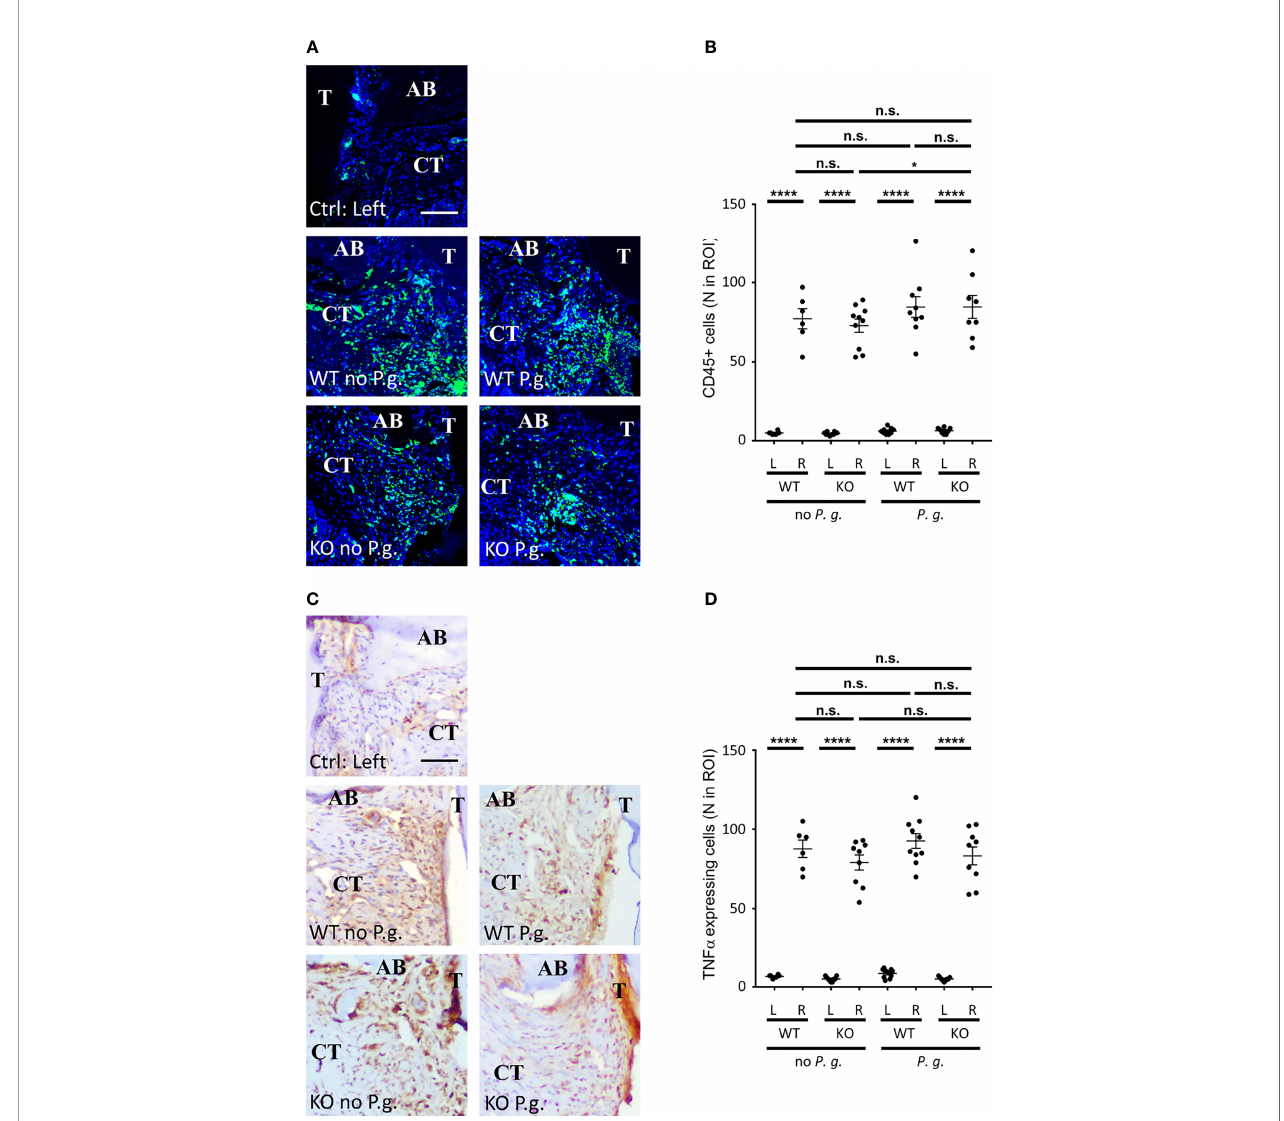
FIGURE 3 | CD45+ cells and TNF- a expression in connective tissue. (A) CD45 expression was revealed by immuno fl uorescence. (B) The number of CD45 + cells in a standardized ROI (ROI = 0.082 mm 2 ) was quanti fi ed. (C) TNF- a expression was revealed by immunohistochemistry. (D) The number of TNF- a -expressing cells (brown staining) in a standardized ROI (ROI = 0.082 mm 2 ) was quanti fi ed. (A, C) The control without periodontitis induction (left side) is shown on the individual upper panel, the assays with ligature with or without P. gingivalis (right side) are shown on the 4 lower panels (CT = connective tissue, AB = alveolar bone), scale bars = 50 m m. (B, D) Each dot represents a single mouse. Horizontal bars represent the mean +/- SEM. Ordinary one-way ANOVA followed by uncorrected Fisher ’ s LSD with a single pooled variance multiple comparison test. *P < 0.05, ****P < 0.0001, n.s. P ≥ 0.05, non-signi fi